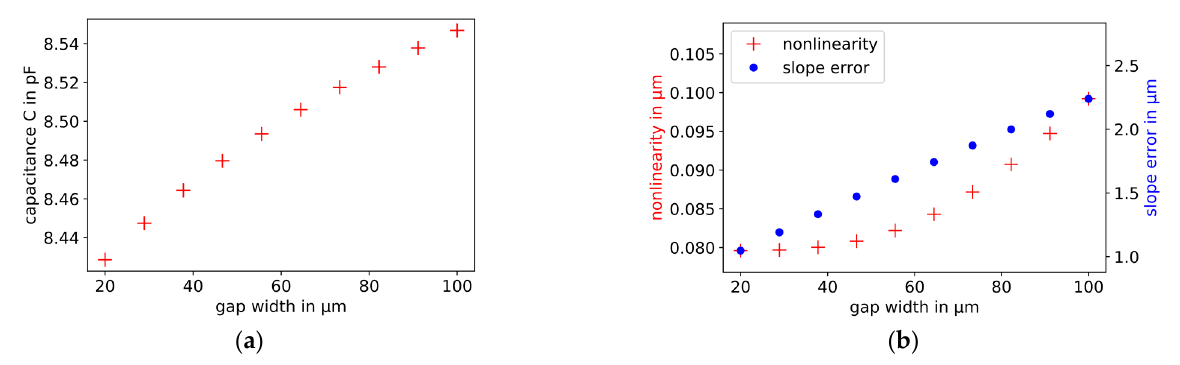
Figure 9. Influence of the width of the gap between the probe electrode and its guard ring on the capacitance ( a ), plate